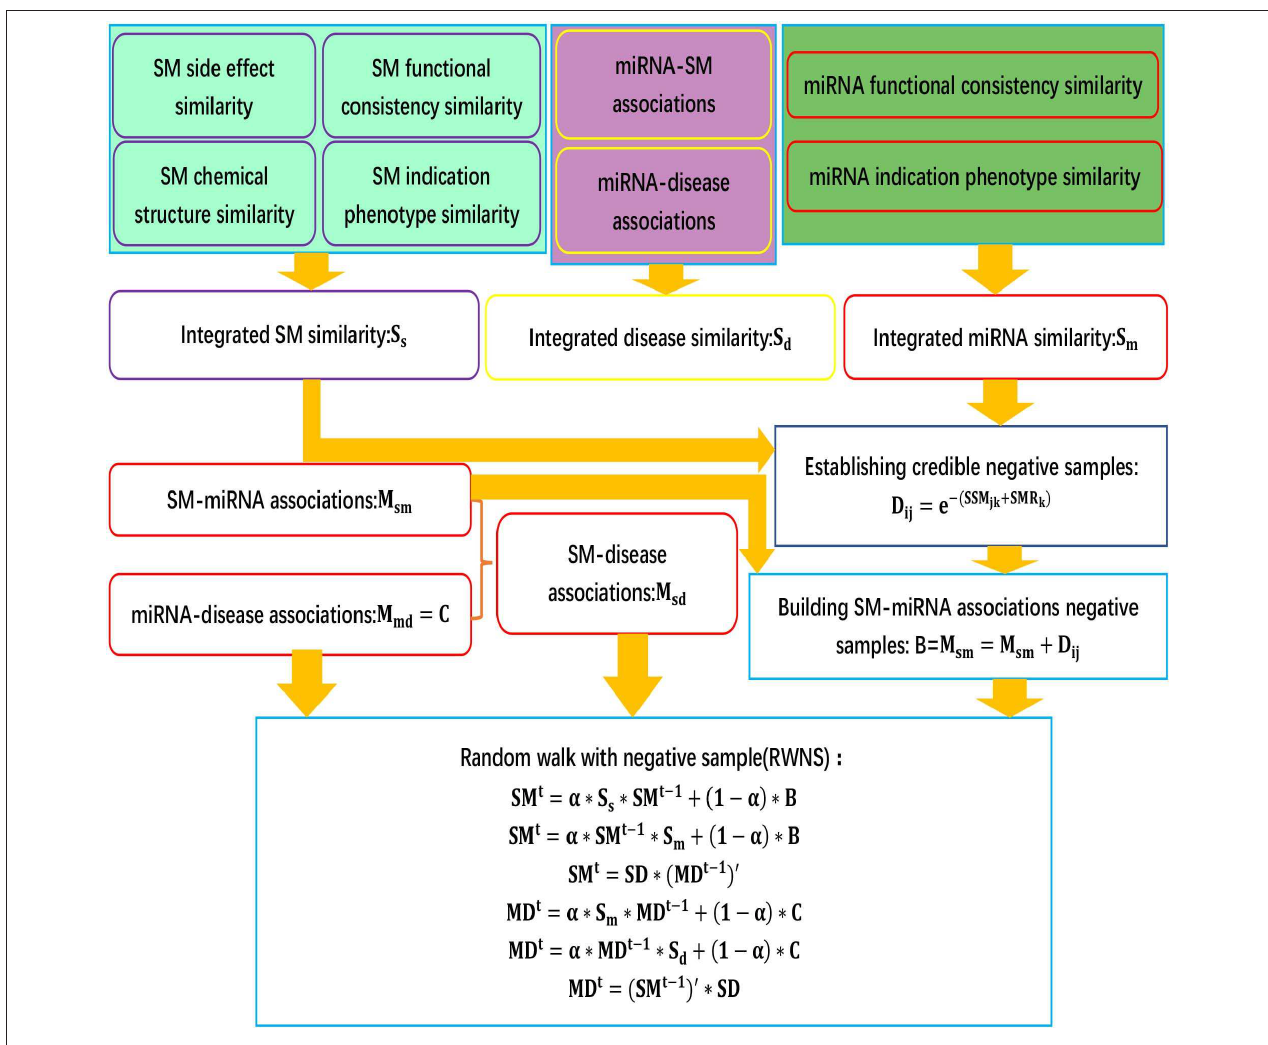
FIGURE 1 | The flowchart of